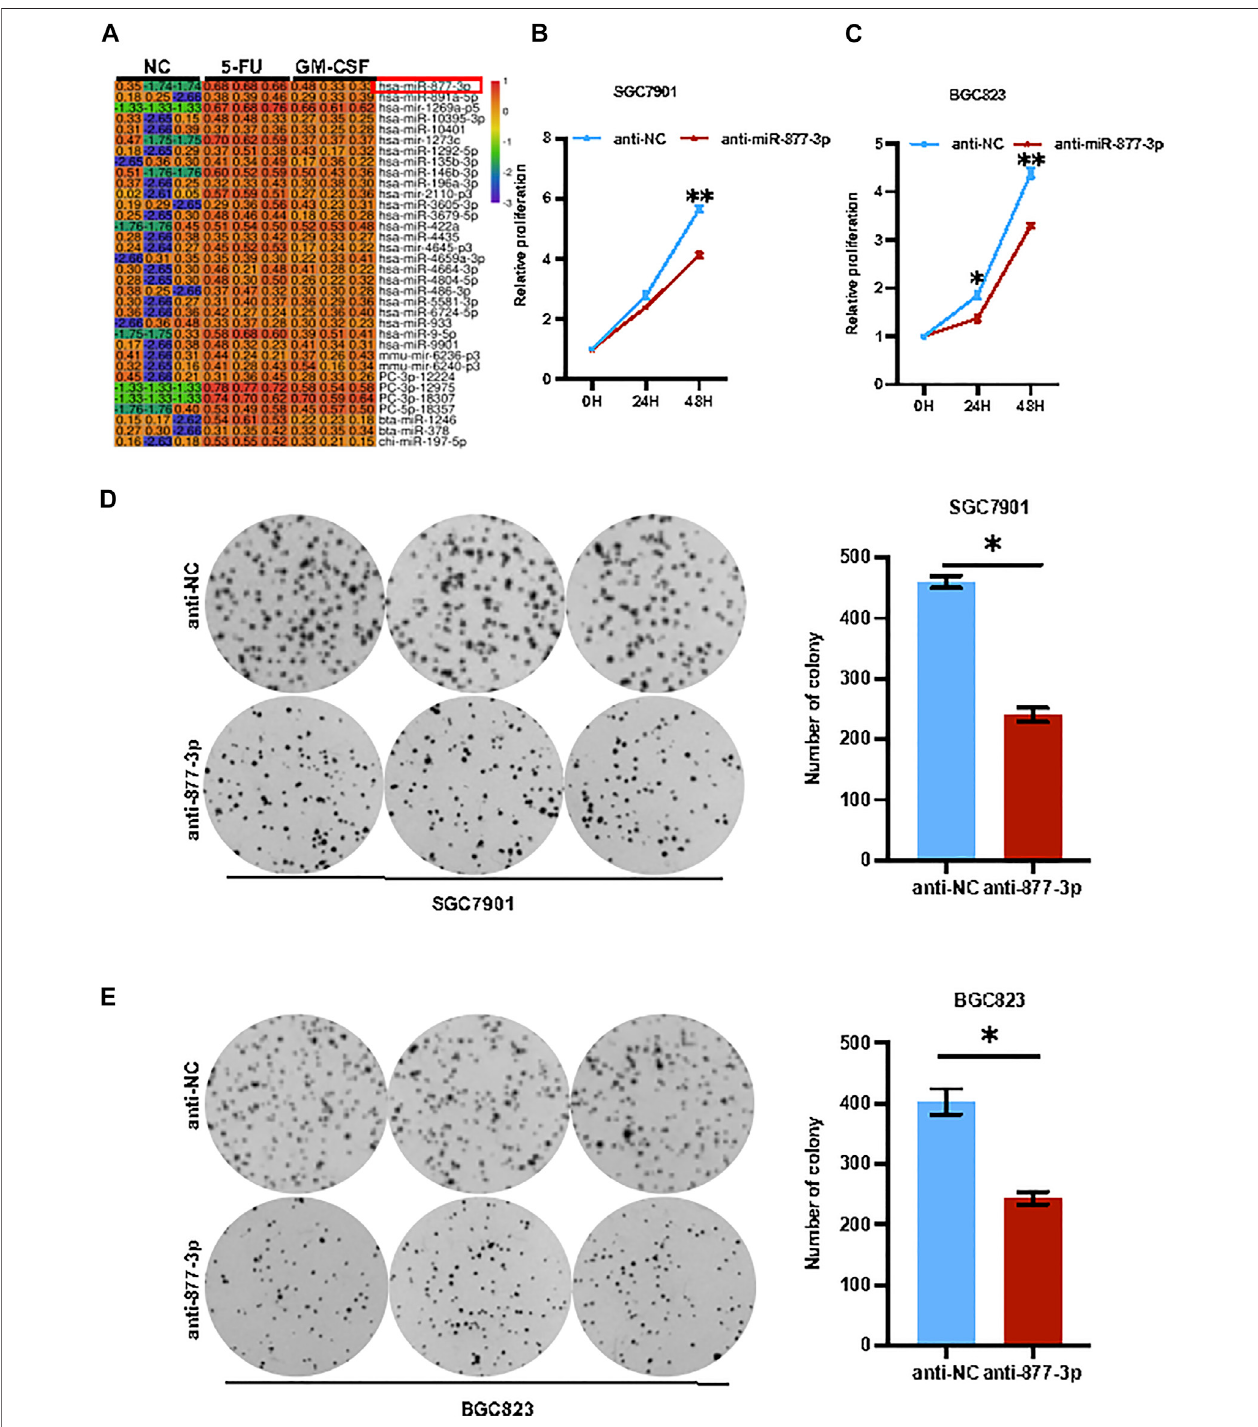
FIGURE 3 | Knockdown of miR-877-3p suppressed gastric cancer cell proliferation. (A) : High-throughput miRNA sequencing analyses on SGC7901 cells with or without stimulation with 5-FU or GM-CSF identi fi ed a group of deregulated miRNAs, including miR-877-3p . (B,C) : Knockdown of miR-877-3p in SGC7901 (B) and BGC823 (C) cells suppressed cell proliferation assayed by CCK8. (D,E) : Knockdown of miR-877-3p in SGC7901 (D) and BGC823 (E) cells suppressed the cellular colony formation. Data are presented as the mean ± SEM ( N = 3). * p < 0.05, ** p < 0.01, *** p < 0.001.